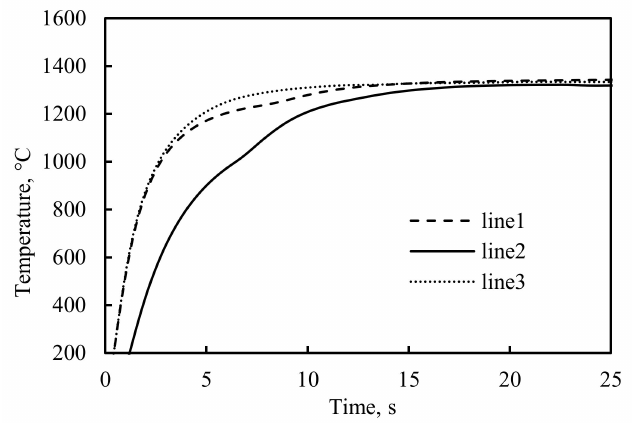
Figure 11. The temperature increase of the bar at di ff erent monitor points for the melting temperature of 1350 ◦ C.